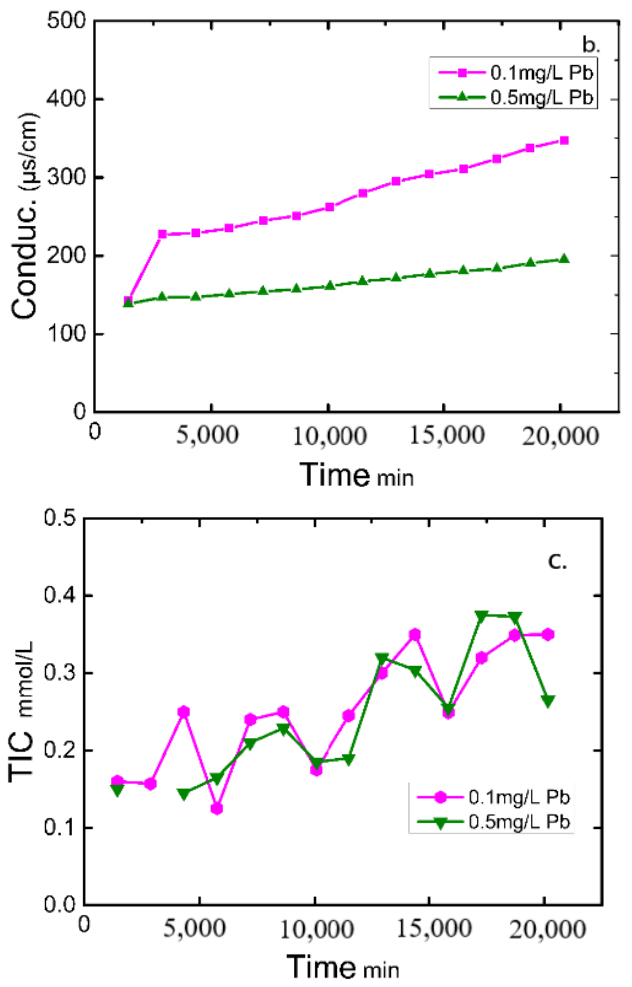
Figure 8. Changes in water chemistry during 21,600 mins of dissolution at different Pb concentra- tions in the open system: ( a ). pH; ( b ). electrical conductivity; ( c ). total inorganic carbon.